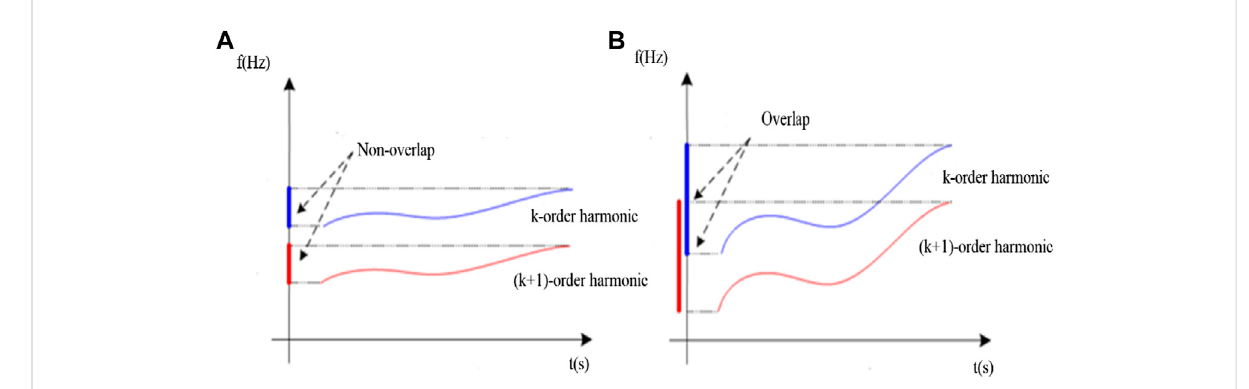
FIGURE 1 Description of the frequency overlap: (A) no overlap; (B) overlap (Wang et al.,